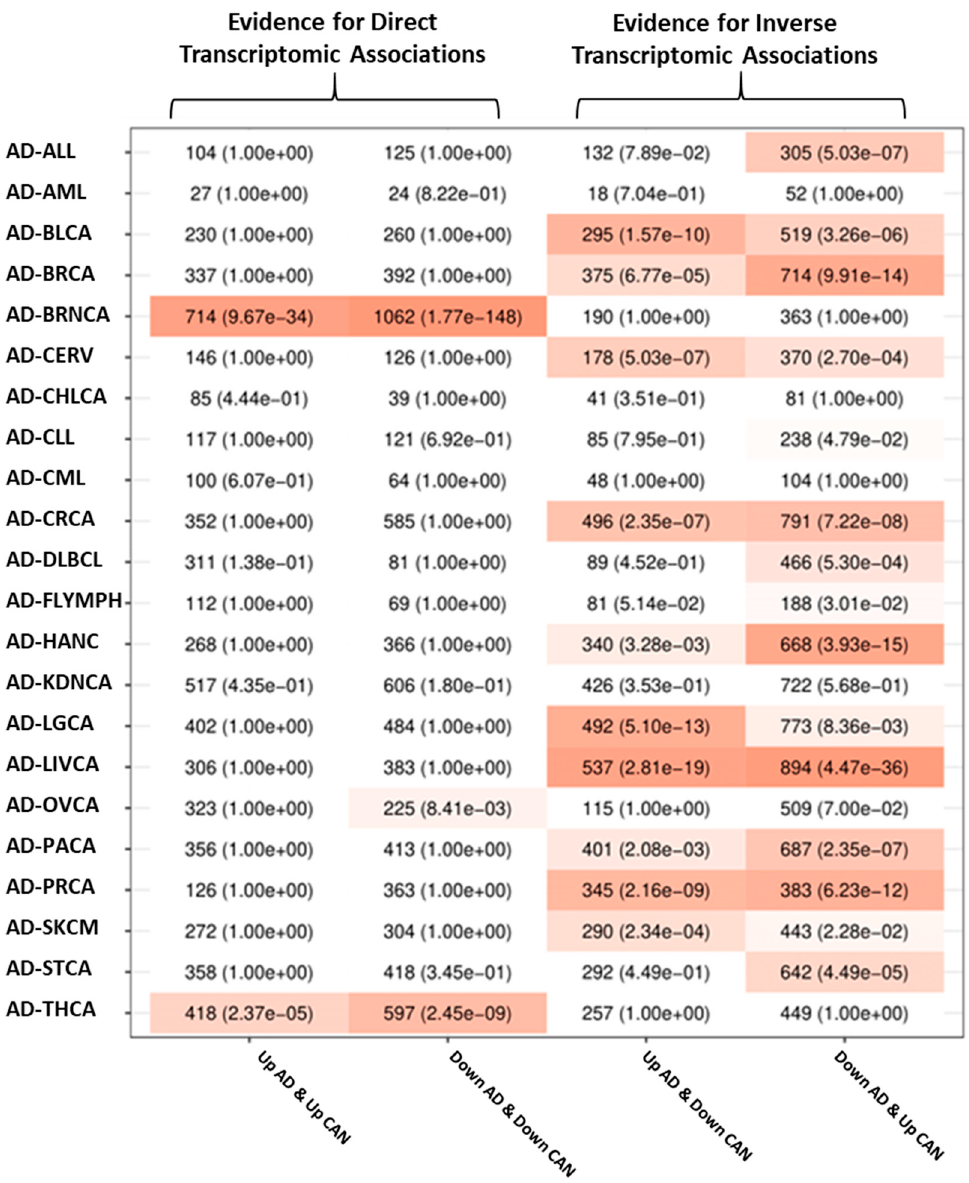
Figure 1. Results of AD and cancer intersection analysis. Each column shows the number of genes at the four possible intersections of up- and downregulated genes in each AD and cancer pair, as well as the FDR-adjusted p -values of Fisher’s exact tests. Column 1 shows genes upregulated in both conditions, column 2 shows genes downregulated in both conditions, column 3 shows genes upregulated in AD and downregulated in each cancer, and column 4 shows genes downregulated in AD and upregulated in each cancer.